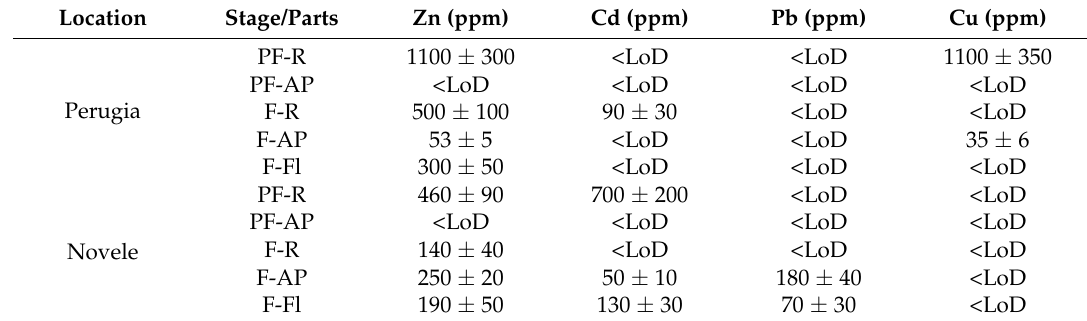
Table 4. Heavy metals (Zn, Cd, Pb and Cu) content of different parts of A. lutea collected from three different locations in Italy